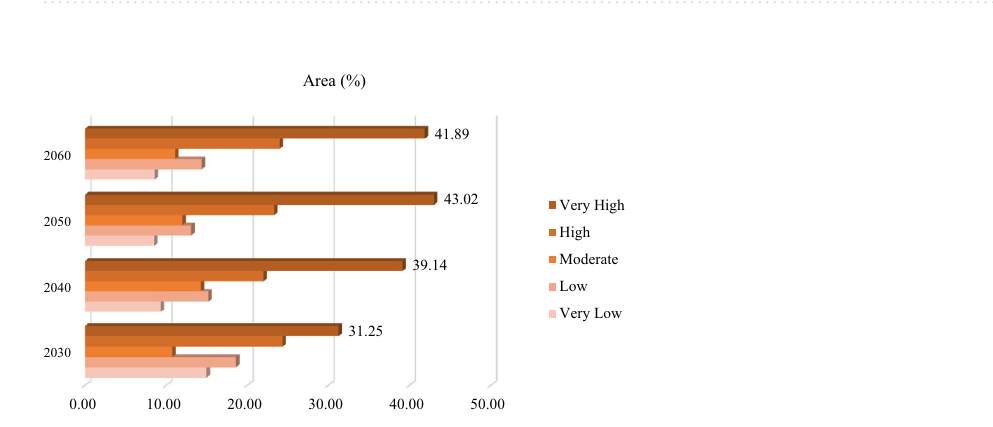
Figure 13. The frost-affected areas variation within the LUB for the years 2030, 2040, 2050, and 2060, generated in Microsoft Excel 2022 software (www. micro soft.